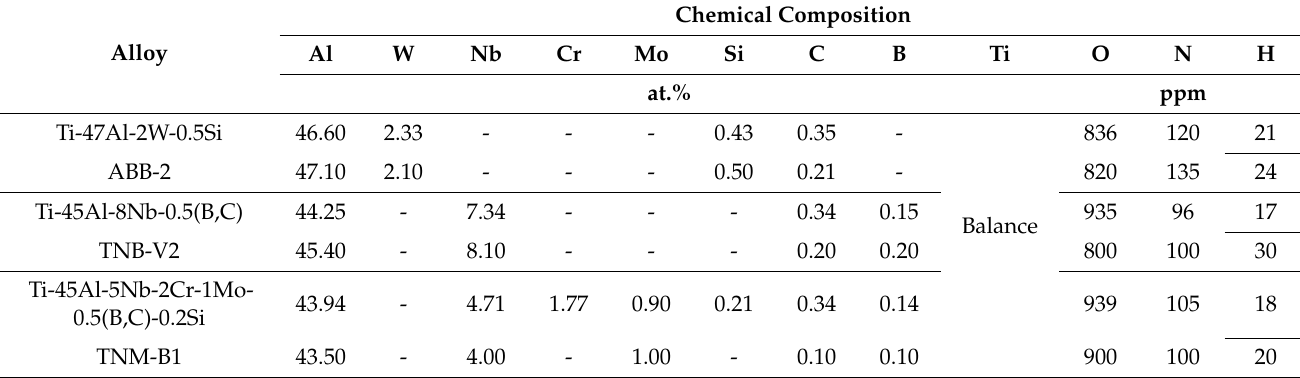
Table 1. Chemical composition of produced and reference alloys.